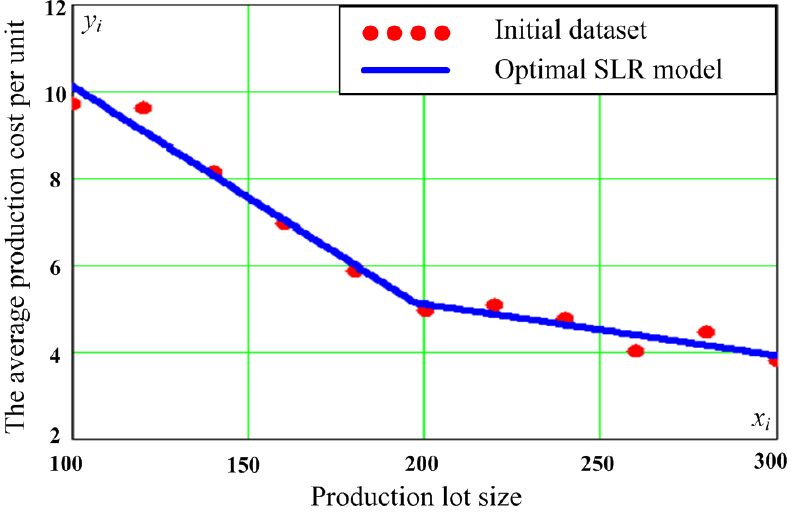
Figure 1. Dataset and final optimal SLR model.